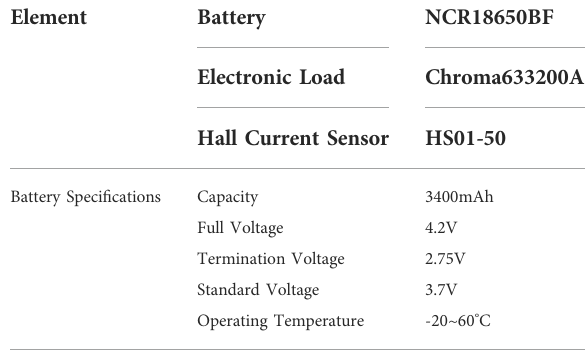
FIGURE 6 SOC estimation error of EKF method under non-constant current source.